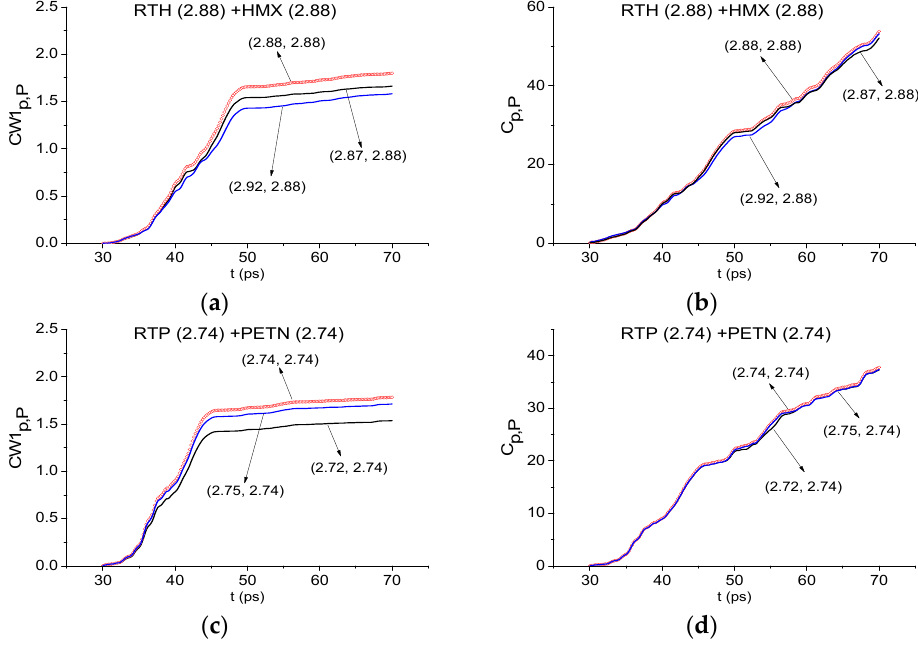
1 CW ( a,c ) and C ( b,d ) detecting the frequencies ν = 2.88 THz ( a,b ) and Figure 17. ICCs , p P , p P Figure 17. ICCs Figure 17. ICCs CW 1 p , P (a,c) and C p , P ( b,d ) detecting the frequencies ν = 2.88 THz ( a,b ) and 2.74 THz ( c,d ) in the RTH and RTP main pulse